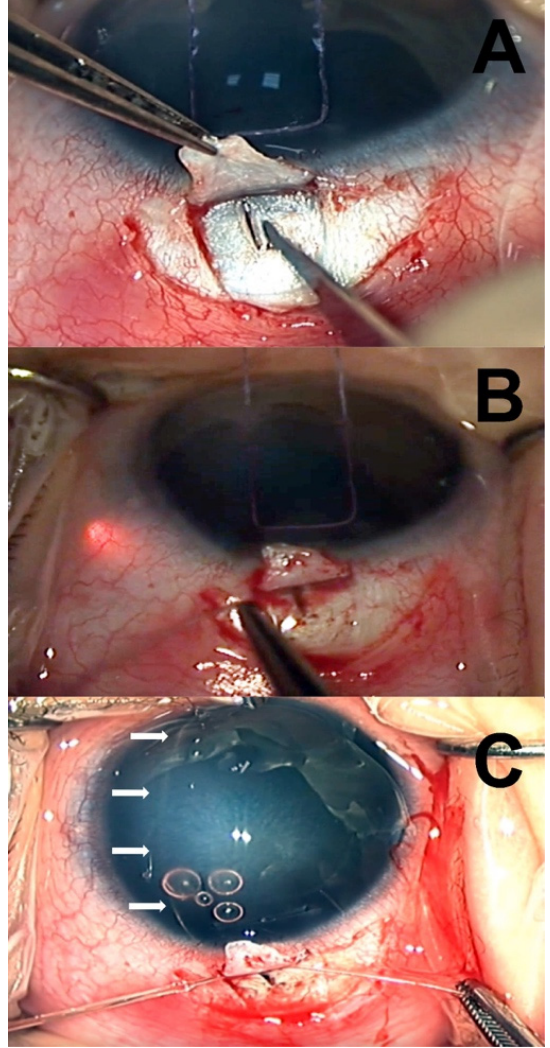
Figure 1. Surgical technique. ( A ) Following conjunctival peritomy, a limbus-based scleral flap is fashioned, then a radial cut in the deep sclera is performed with a slit knife, posteriorly to the limbus, and progressively deepened until the outer wall of the Schlemm canal (SC) is cut. ( B ) An illuminated microcatheter (iTrack 250A; iScience Interventional, Menlo Park, CA, USA) is advanced along the canal circumferentially for 360 ◦ . ( C ) Once circumnavigation of the SC is accomplished, both ends of the microcatheter are pulled, creating a 360 ◦ internal opening of the SC and trabecular meshwork. In cases where the microcatheter tip met with an obstruction within SC or became misdirected, catheterization was attempted in the opposite direction, and viscoelastic was injected through the microcatheter in attempt to dilate the canal. If SC could not be identified, catheterization was tried at a different quadrant (supero-temporal or infero- temporal). Once circumnavigation of the SC was accomplished, the anterior chamber was deepened by injecting dispersive viscoelastic (Eyefill, Bausch and Lomb, Bridgewater,